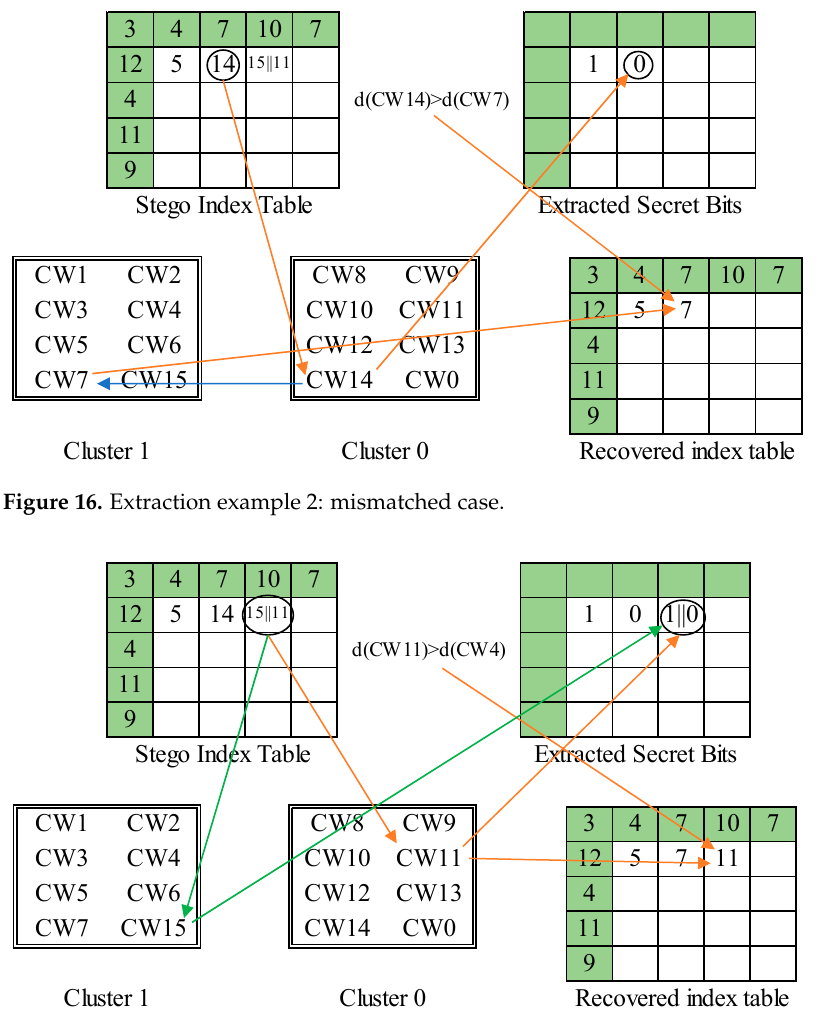
Figure 17. Extraction example 3: abnormal block.